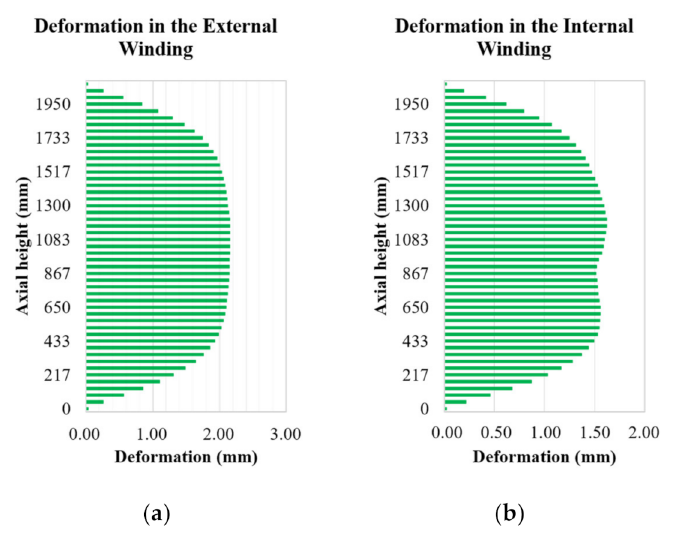
Figure 16. Total deformation due to the action of magnetic forces and thermal expansion ( a ) in external winding, ( b ) in internal